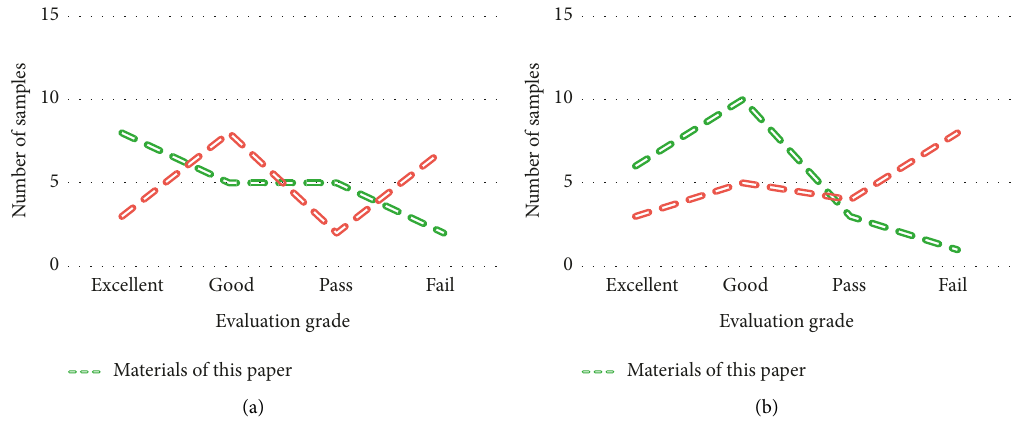
Figure 10: Suspension and bursting strength test. (a) shows the drape test of two design materials. (b) shows the burst strength test of the two design